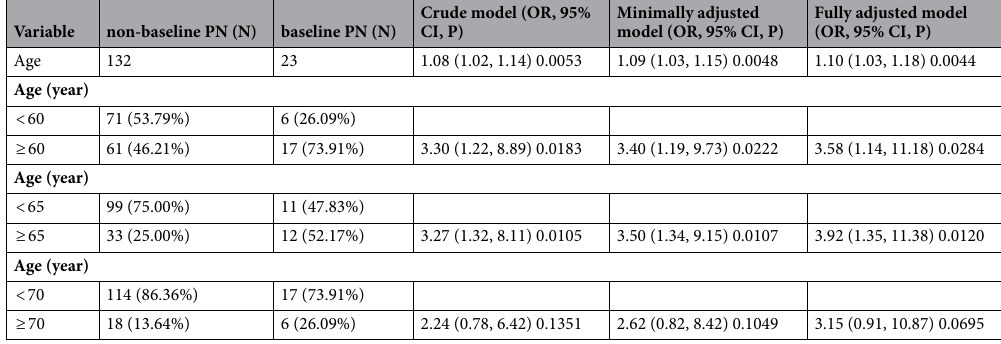
Table 2. Variable-adjusted binary Logistic regression analysis between age and the baseline PN. Statistical method: variable-adjusted binary Logistic regression. Crude model adjust for: None. Minimally adjusted model adjust for: gender, immunoglobin type, light chain type. Fully adjusted model adjust for: gender, BMI, immunoglobin type, light chain type, DS stage, Creatinine, β2 microglobulin, lactate dehydrogenase. PN peripheral